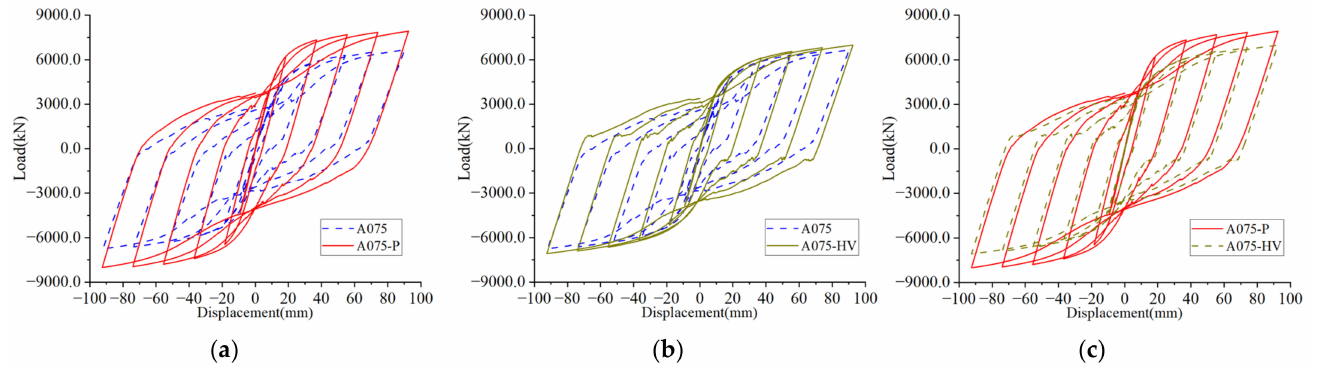
Figure 16. Hysteretic performance comparison of SPSWs. ( a ) A075 and A075-P hysteresis curve comparison. ( b ) A075 and A075-HV hysteresis curve comparison. ( c ) A075-P and A075-HV hysteresis curve